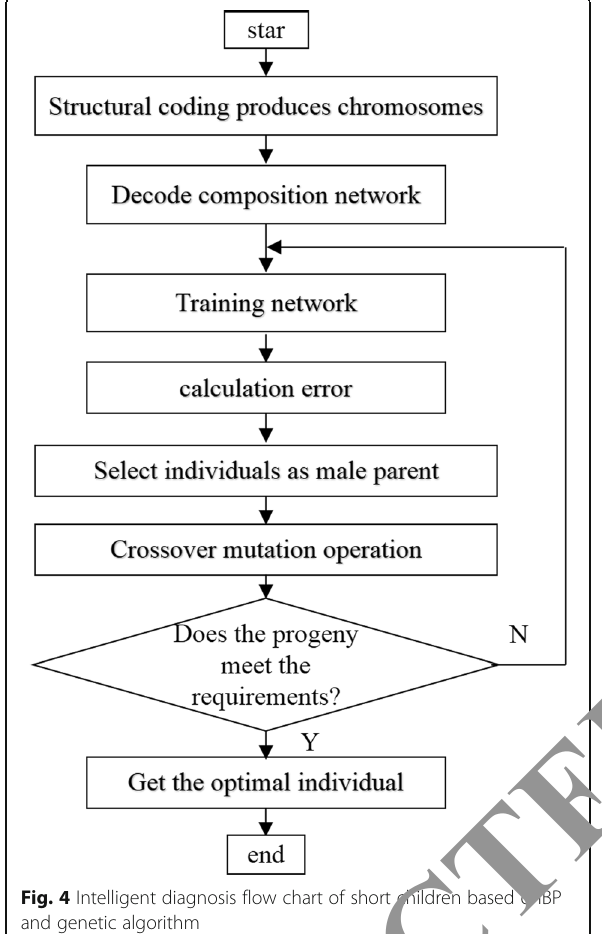
Fig. 4 Intelligent diagnosis flow chart of short children based onBP and genetic algorithm